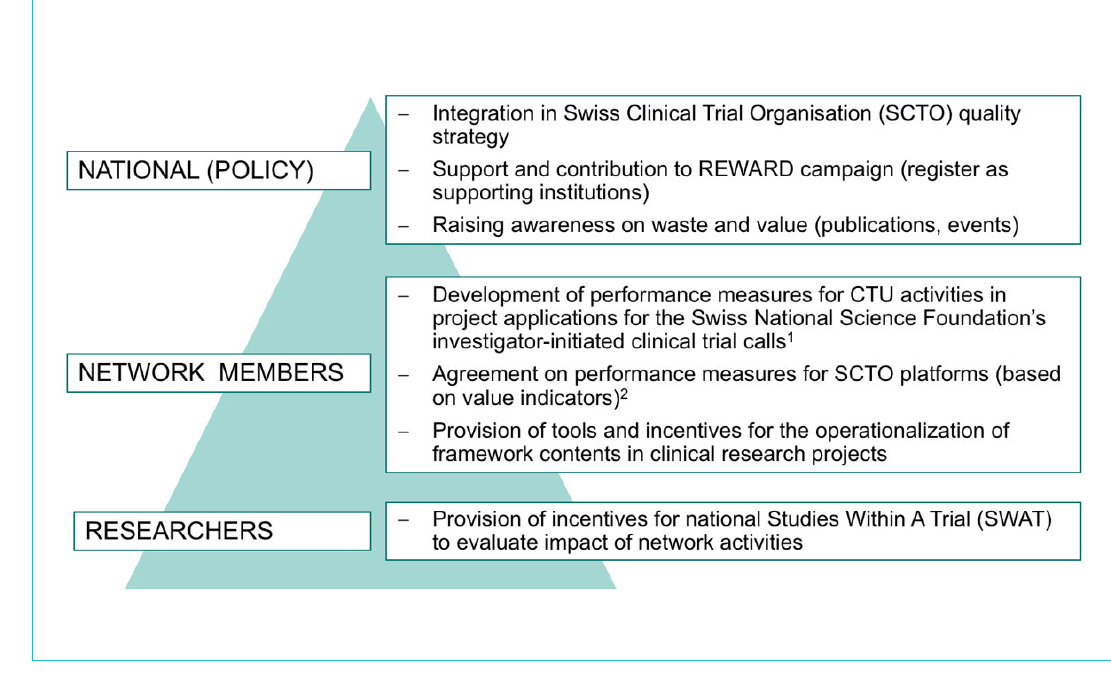
Figure 4: Roadmap on increasing value in Swiss academic clinical research. 1 The CTU Network and SCTO actively support the design, plan- ning, and conduct of investigator-initiated studies that apply for the SNSF’s call for investigator-initiated clinical trials [35]. Integrating perfor- mance measures would facilitate a subsequent assessment of the CTU Network’s impact on the success of supported studies. 2 The SCTO Platforms are centres of excellence to provide support on specific areas of expertise, e.g. data management, statistics and methodology, and education and training, and are hosted by different